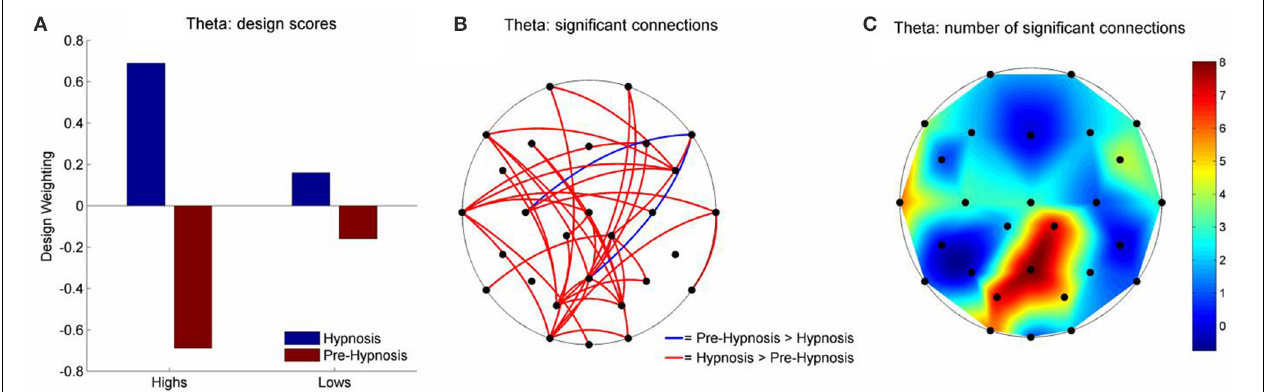
FIGURE 2 | Schematic representation of the change in iCOH between the pre-hypnosis and hypnosis states in Theta. (A) Shows the Design Scores for the significant LV which was a contrast between the pre-hypnosis and hypnosis states predominantly for the high susceptible participants. (B) Shows those connections that significantly loaded on the LV, red lines showing a positive loading and blue lines showing a negative loading. Given